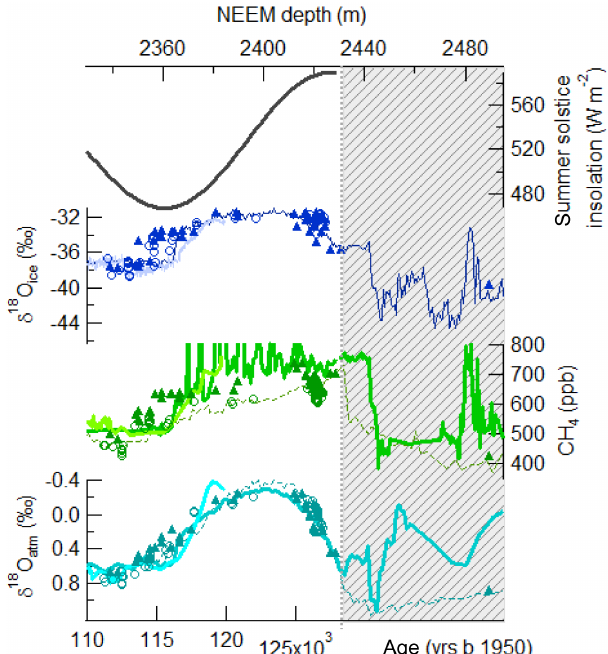
Figure 1. Synchronized Greenland δ 18 O ice records. From top to bottom: summer solstice insolation at 77 ◦ N (black); δ 18 O ice from NGRIP (light blue line), GRIP (open circles) and GISP2 (triangles) on the AICC2012 timescale (bottom axis) and NEEM δ 18 O ice (dark blue line) on its depth scale (top axis); CH 4 records from NGRIP (light green line), GRIP (open circles), GISP2 (triangles) and EDC (dashed line) on the AICC2012 timescale and NEEM (dark green line) on its depth axis; δ 18 O atm records from NGRIP (light blue), GRIP (open circles), GISP2 (triangles) and EDC (dashed line) on the AICC2012 timescale and NEEM δ 18 O atm (turquoise) on its depth axis. The shaded grey rectangle highlights the deepest part of the NEEM records, where no gas synchronization with Antarctic ice core records from the penultimate glaciation is